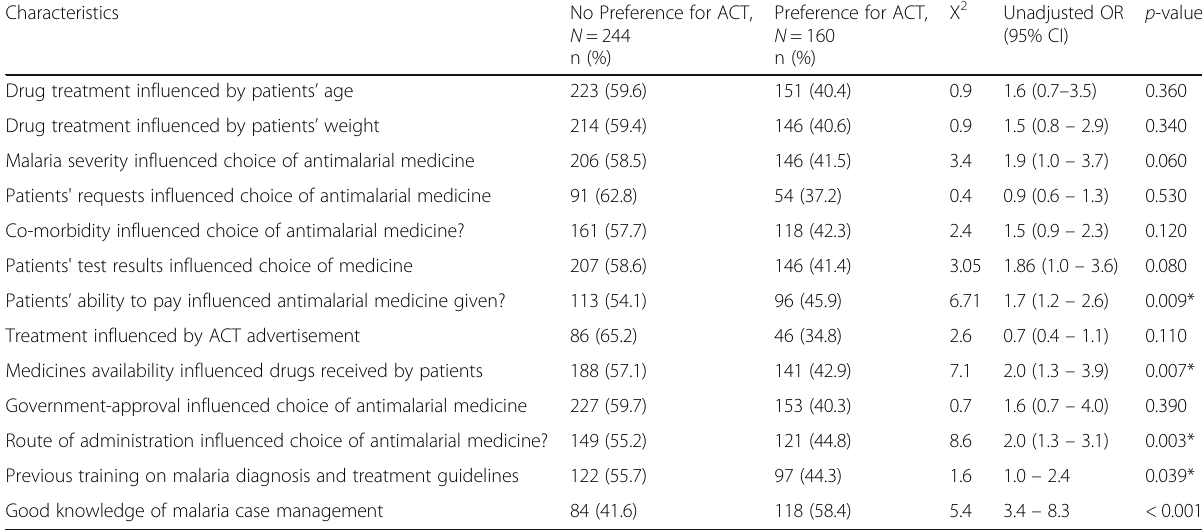
Table 4 Association of patient and human resource related factors with preference for ACT, Lokoja, North-Central Nigeria